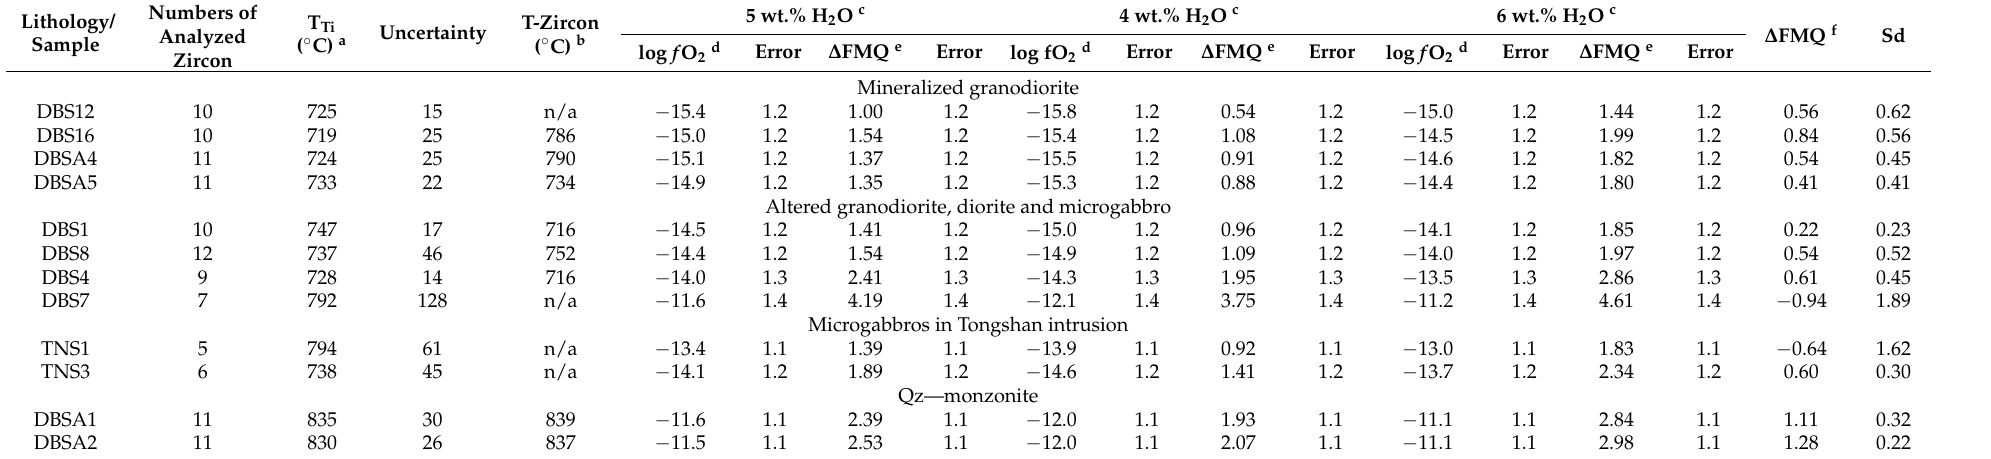
Table 2. Calculated average Ti-in-zircon temperature ( ◦ C) and oxidation states (log f O 2 and ∆ FMQ) in individual samples from the Duobaoshan-Tongshan intrusions. Lithology/